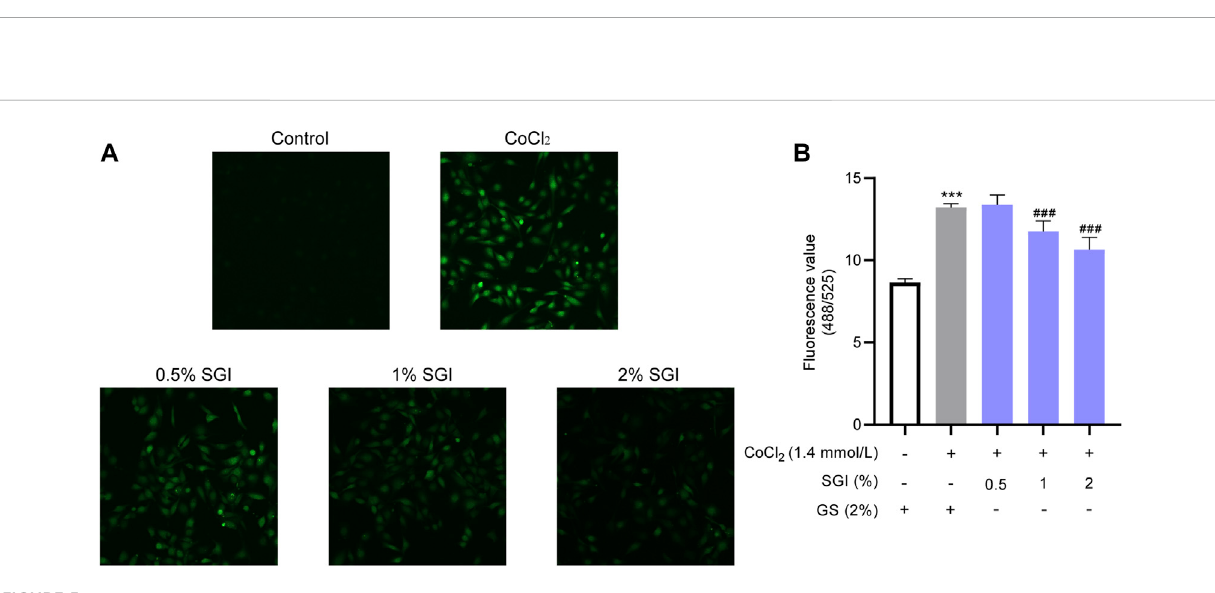
FIGURE 5 SGIreducesintracellularROSproduction.RepresentativeCLSMimagesofROS (A) andintracellularROSlevel (B) .*** p < .001vs.thecontrolgroup; ### p < .001 vs. the CoCl 2